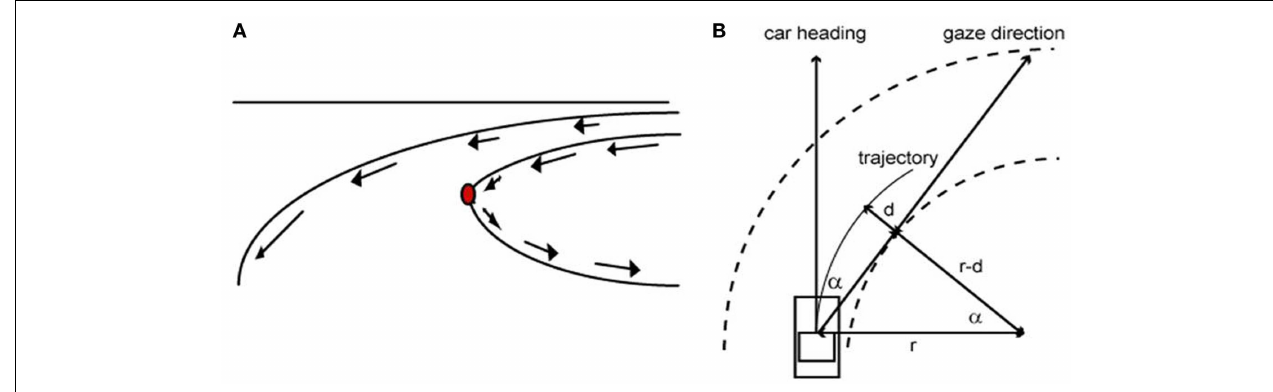
follows the bend, looking toward the tangent-point provides a prediction of the road curvature (after simplification, 1/ r = α 2/2 d